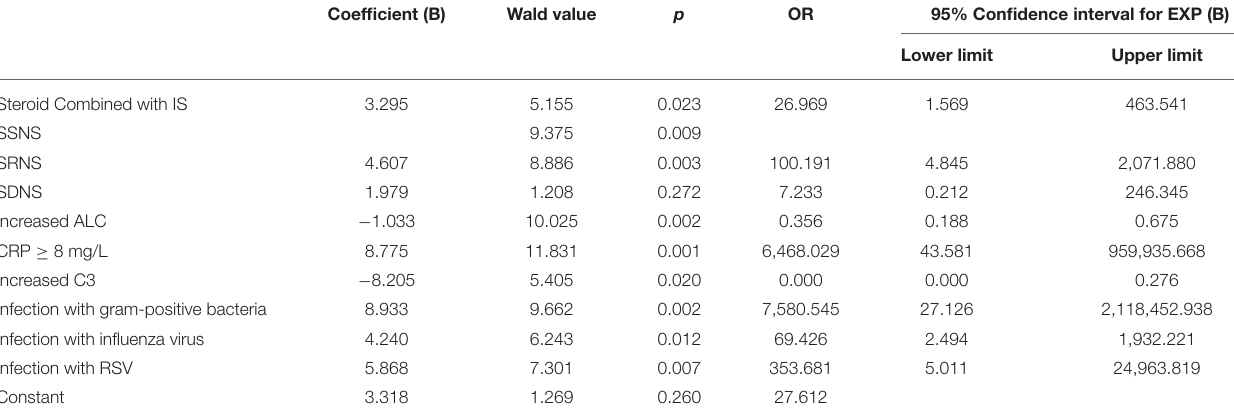
TABLE 5 | Binary logistic regression analysis of risk factors of severe infections in children with